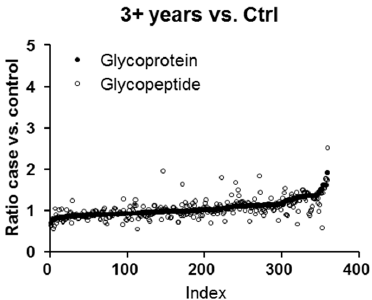
Figure 1. Global comparison of glycoprotein and matched glycopeptide profiles across the time groups. Case versus control (Ctrl) ratios for glycoproteins were indexed in order of increasing ratio for each prediagnosis time group and plotted with ratios of matching glycopeptides. Protein ratios are repeated for proteins with multiple matched glycopeptides.